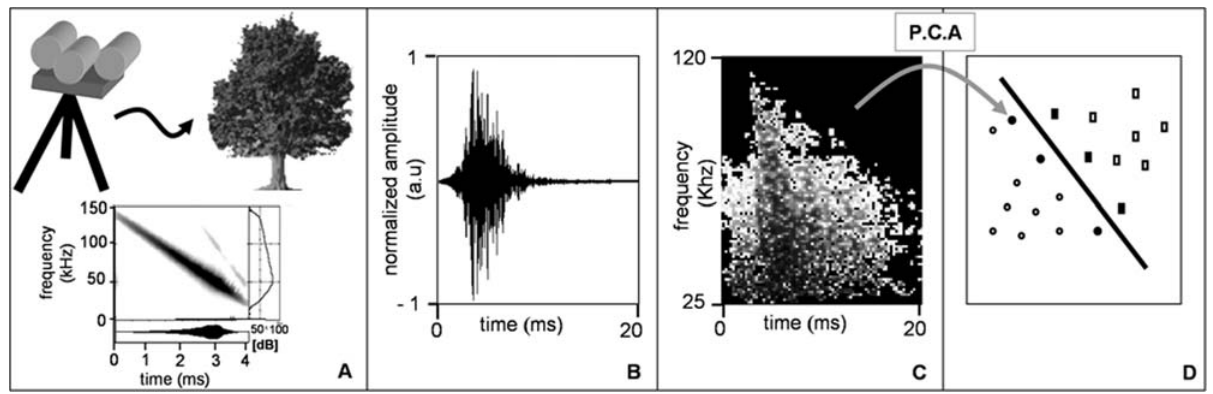
Figure 9. Summary of the materials and methods. (A) The basic setup of the experiments, in which a sonar head on a tripod was used to ensonify plants. The emitted signal’s spectrogram is presented with the time signal under it and the frequency dependent intensity curve on the right. (B) An example of a time domain back scatter recorded from a single apple tree. The amplitude is in arbitrary units. (C) The spectrogram of the time domain signal of B, created after cutting the echo out of the time signal. The spectrogram’s frequency range was cut between 120–25 kHz, and it was threshold leaving only the regions that are high above noise. (D) An illustration of the classification by SVMs. Following PCA, each spectrogram is represented by a 250-dimentional data point (shown in the figure as a 2-dimentinal point) belonging to one of two classes (circles or rectangles). The SVM then learns the best hyperplane for the training data. The data points that are closest to the hyperplane (denoted as full shapes) are called the support vectors and define the orientation of the hyperplane.